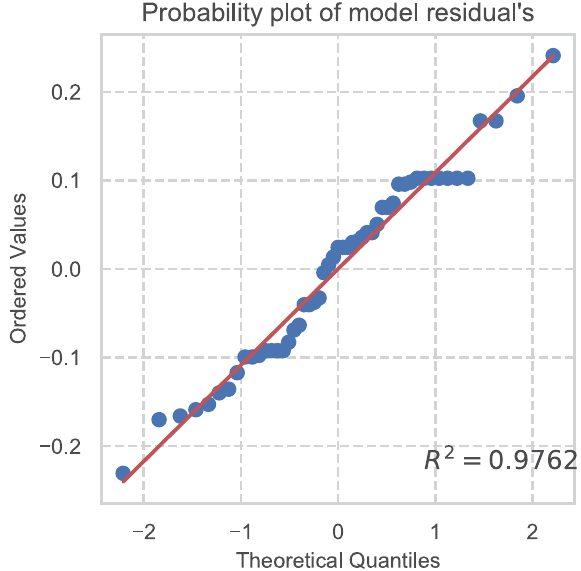
Figure 7. Probability plot of ordered values versus theoretical quantiles.